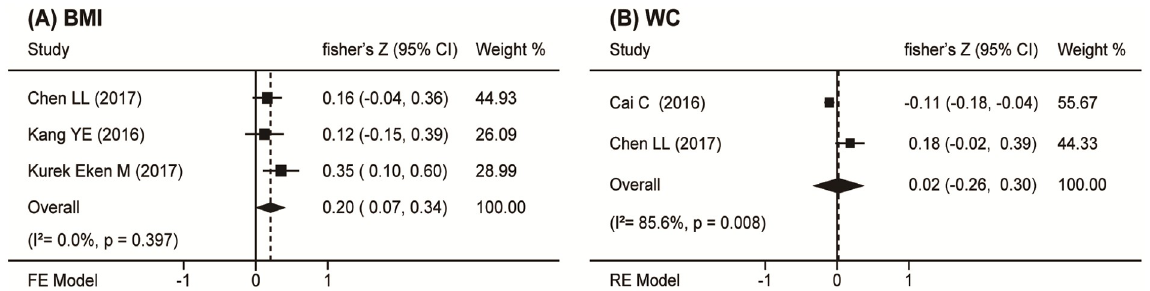
Fig 6. Forest plot of the association between circulation Nrg4 levels and obesity markers in DM. Summaries are shown of the association circulation Nrg4 levels and (A) BMI and (B)